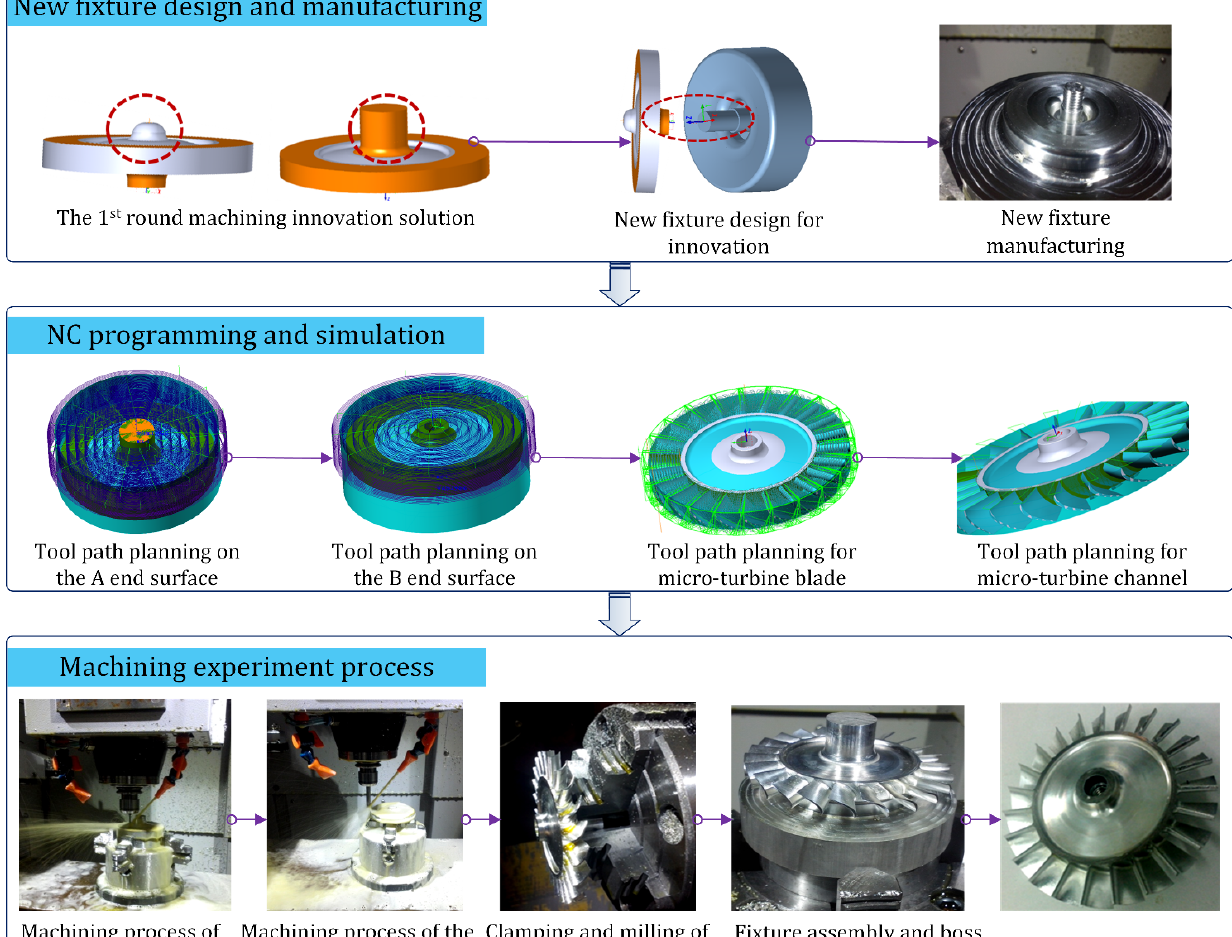
Figure 9. Machining process innovation experiment of the micro-turbine.